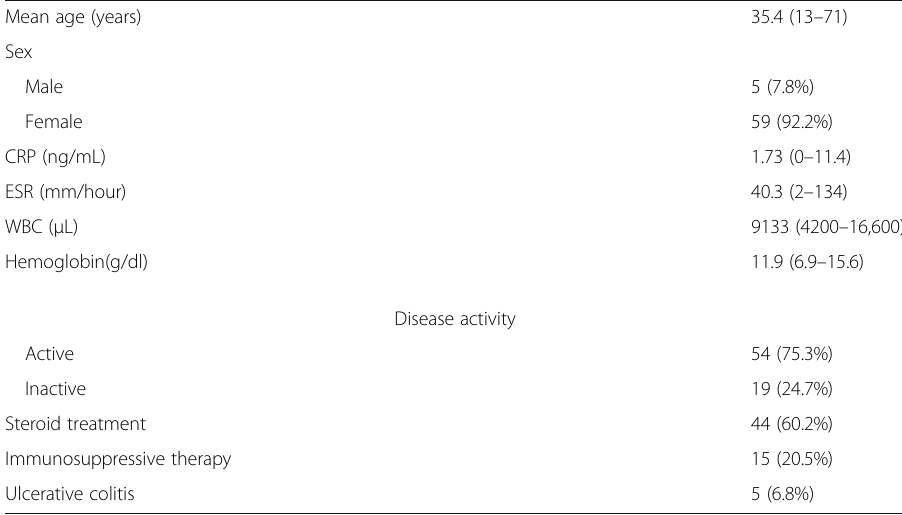
Table 1 Baseline characteristics of patients (64 patients, 73